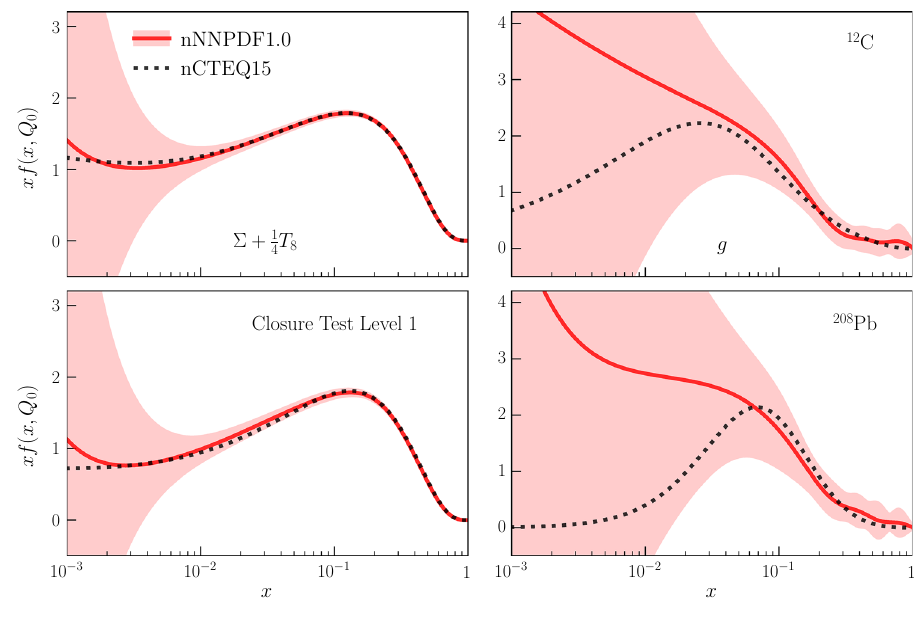
Fig. 7. While the PDF uncertainties will generally decrease with the number of iterations, this may not necessarily be true between data points (interpolation) and outside the data region (extrapolation). The latter is known as the extrapola- tion uncertainty, and is present even for a perfect fit for which the χ 2 vanishes. In our fits, the extrapolation region can be assessed from Fig. 1, where x ∼ < 0 . 01 and x ∼ > 0 . 7 are not directly constrained from any measurement in